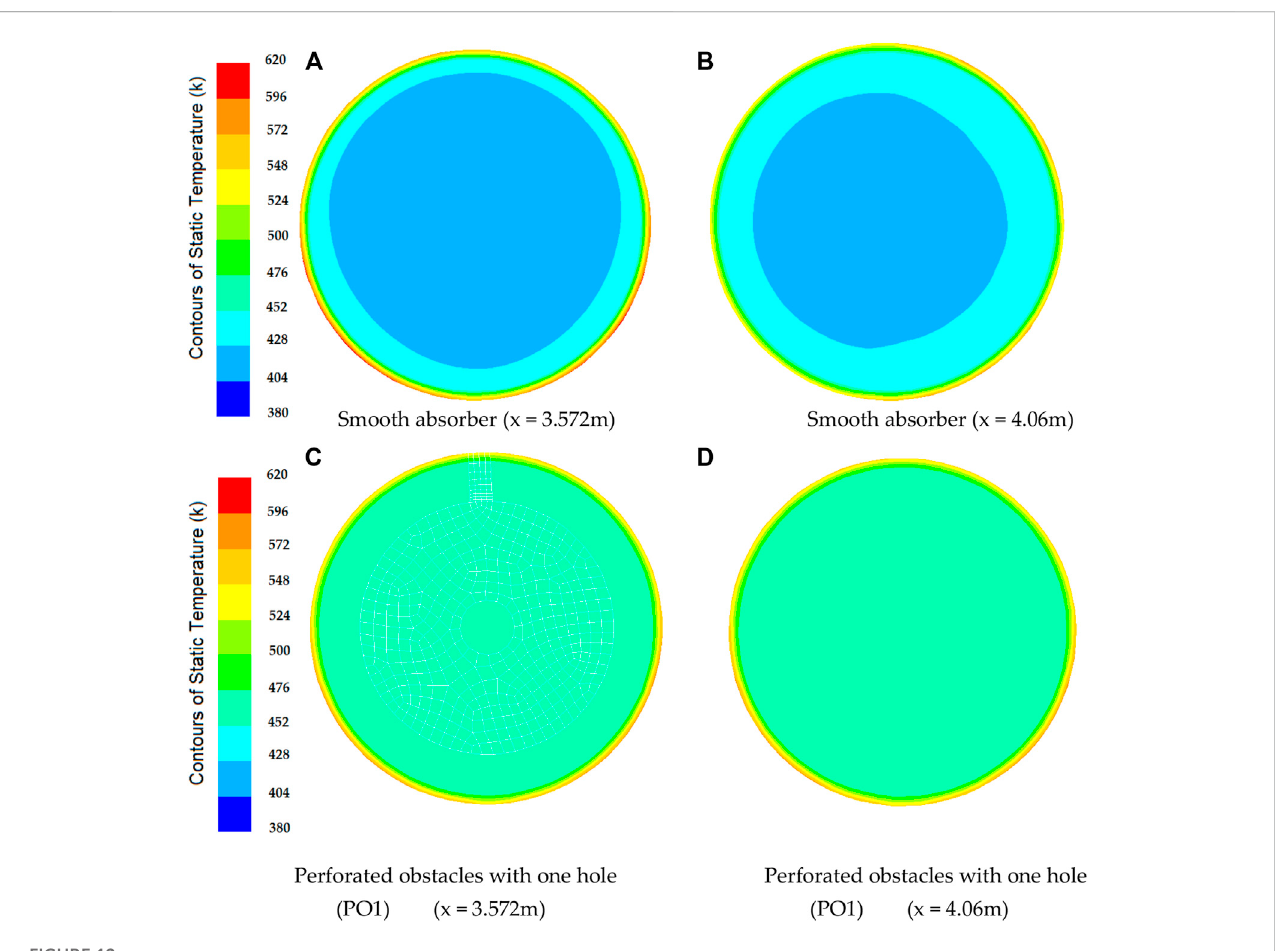
FIGURE 12 Temperature distribution of absorber tube of PTR at cross-sections with Re = 81728.